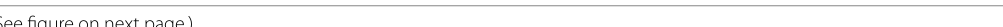
figure on next Fig. 4 BIBN4096BS treatment reduced overexpression of synaptic associated proteins and restored the aberrant synaptic ultrastructure in VN after CM. Representative western blot bands and densitometric quantification of PSD-95 ( A ), Syp ( B ) and Syt-1 ( C ) after CM. n D Representative images of the synaptic ultrastructure in VN after CM. Quantitative analysis of PSD thickness ( E ), length of synaptic activity zone ( F ), and curvature of synaptic interface ( G ) after CM. n 3/group. Representative images ( H ) and quantitative analysis ( I ) of the density of dendritic = spines in VN after CM. n 3/group. Results are mean SD. One-way ANOVA, Dunnett; * p < 0.05 compared with saline group, # p < 0.05 compared = ± with CM